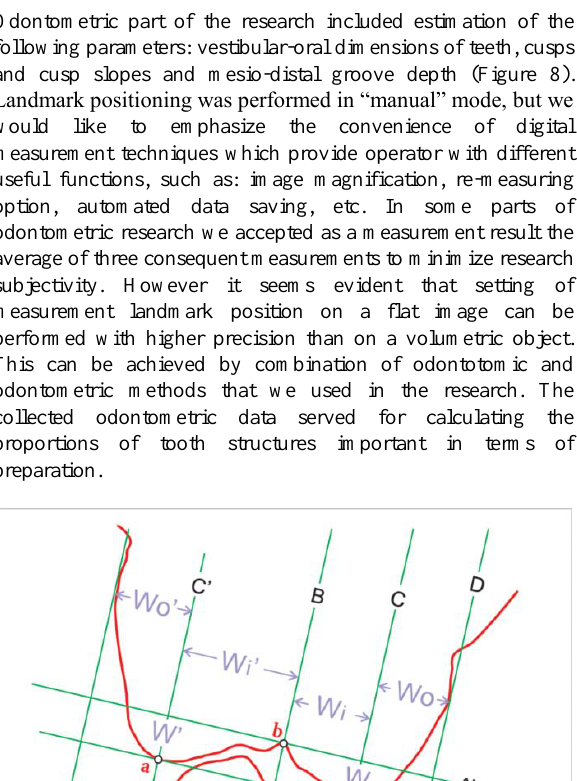
Figure 7. Measurement landmarks on a tooth contour